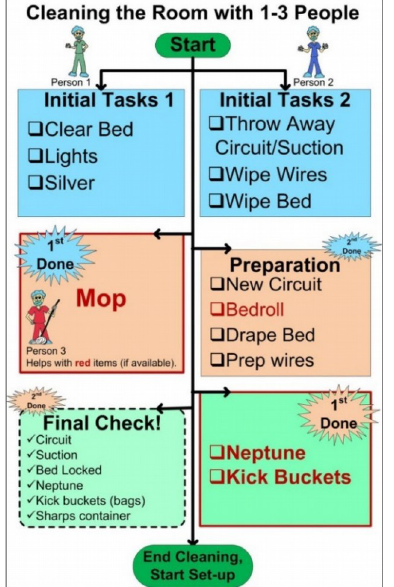
Figure 12. Cleaning Procedure